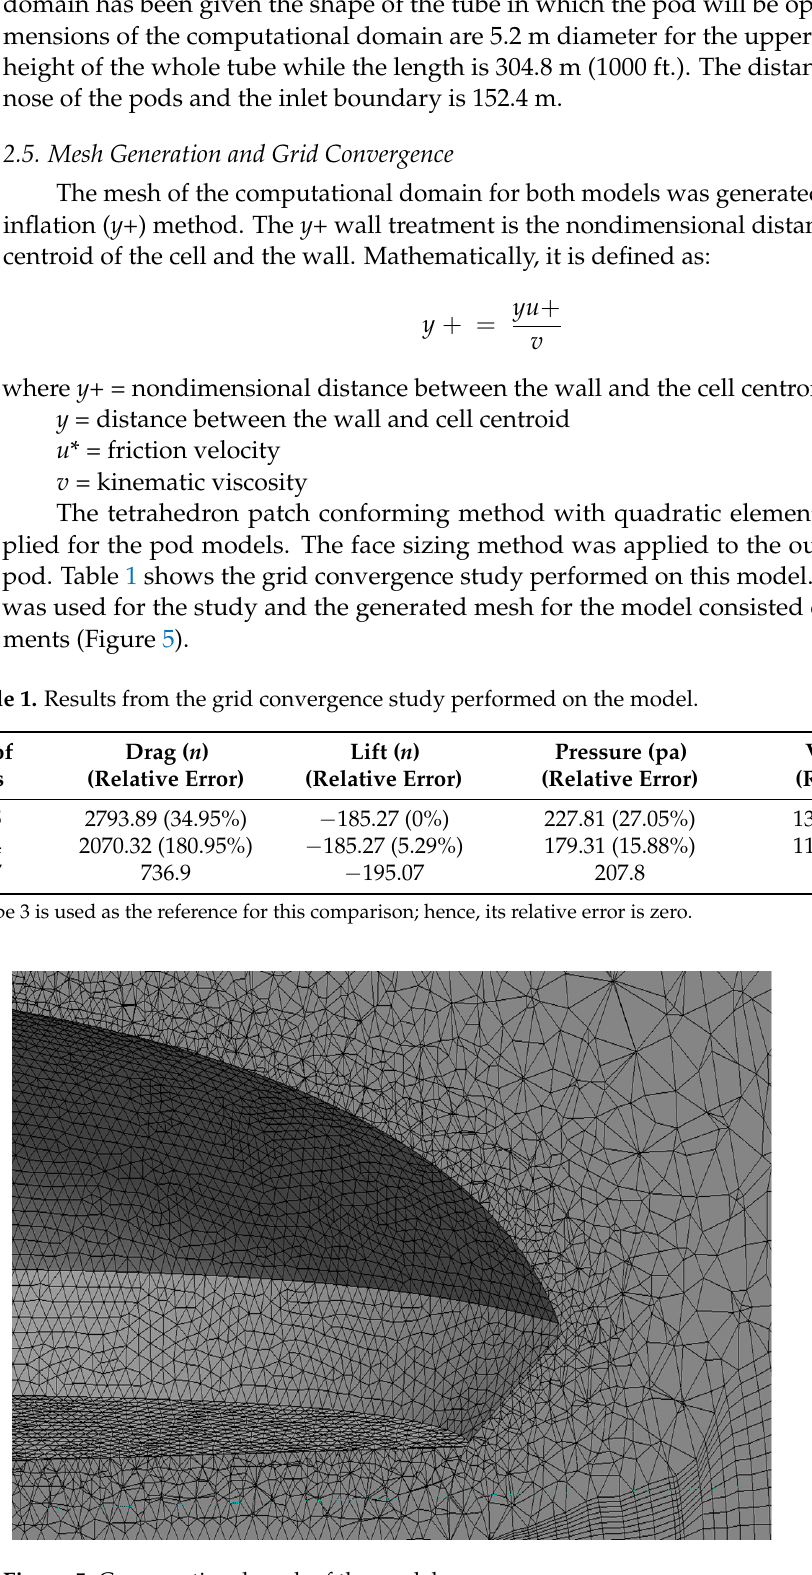
Figure 5. Cross-sectional mesh of the model.